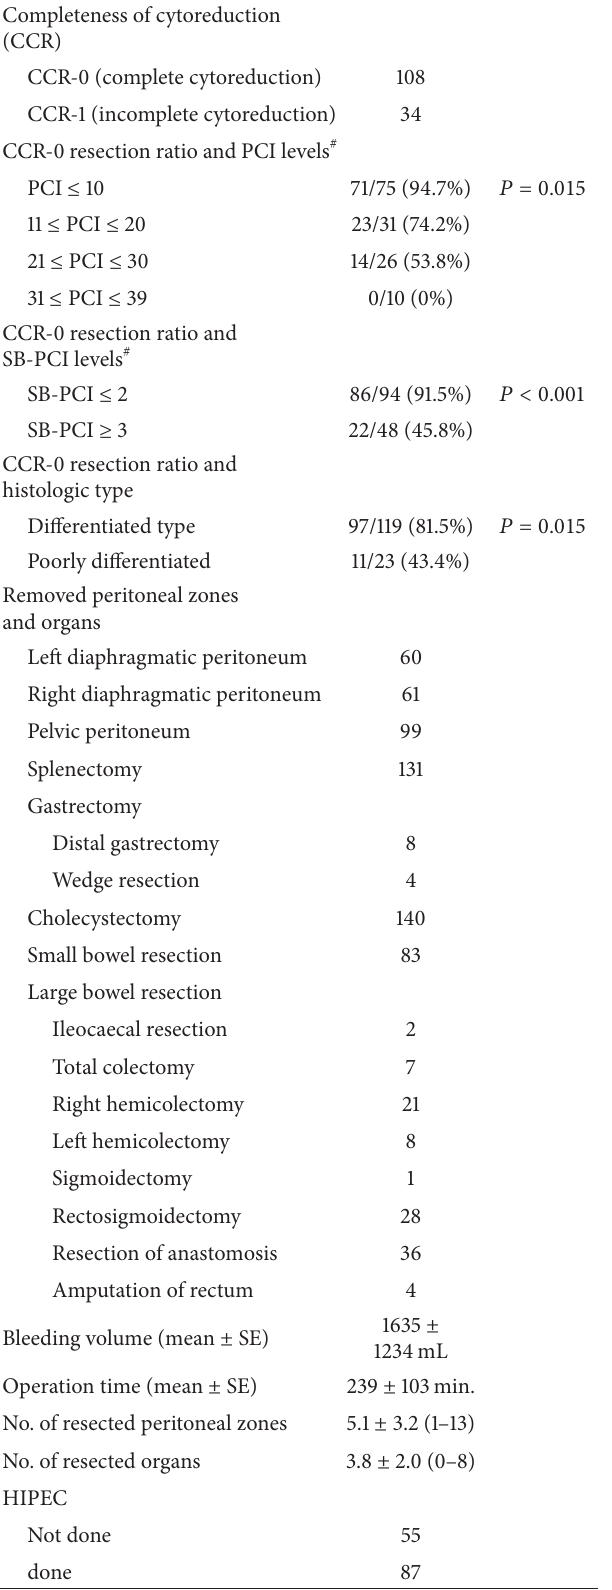
Table 2: Operation methods.